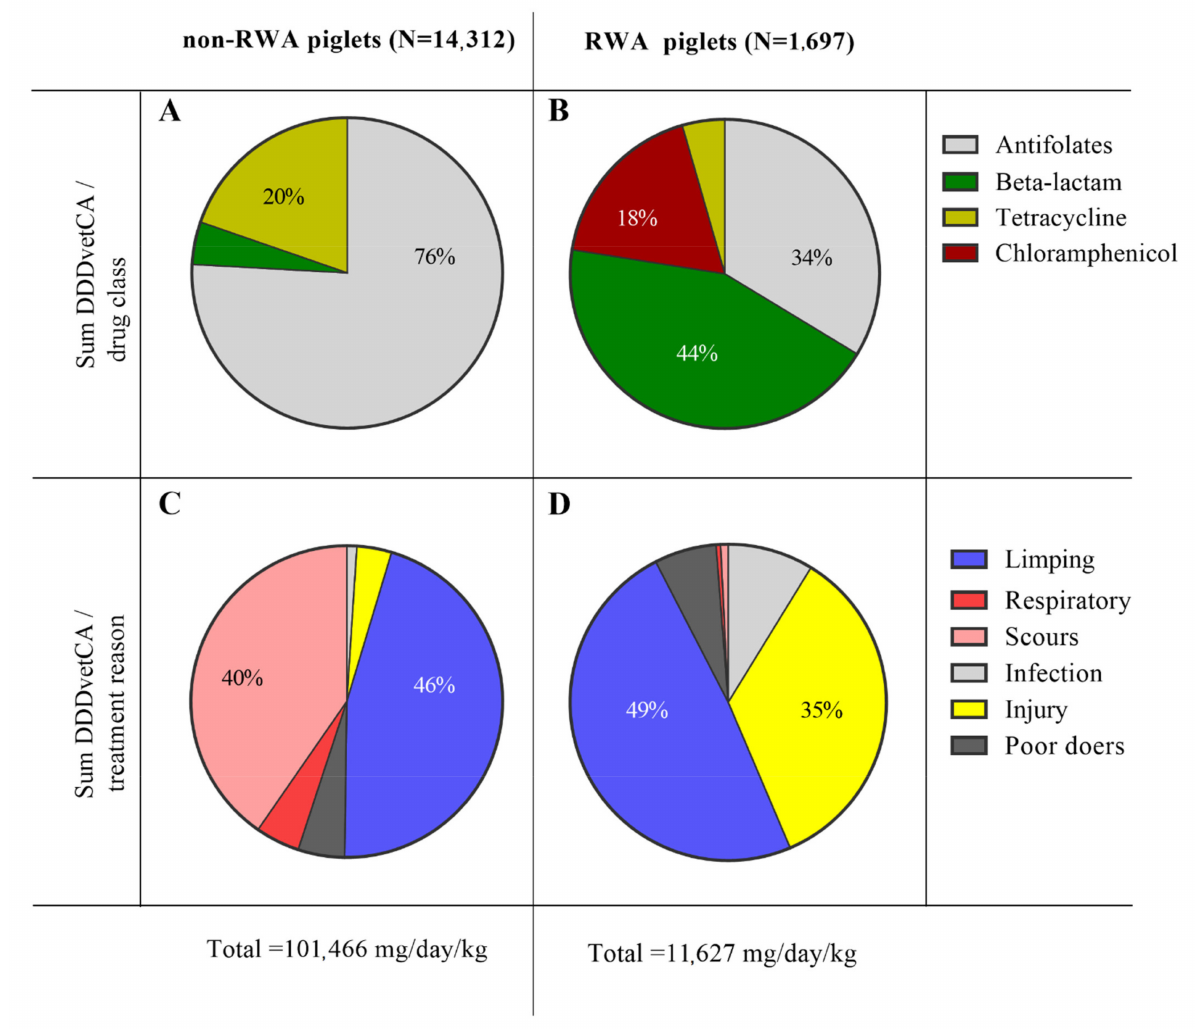
Figure 1. Summary of records from non-RWA and RWA participating farms showing the total DDDvetCA value of antibiotic classes administered to piglets ( A , B ), along with clustered diseases and treatment reasons ( C , D